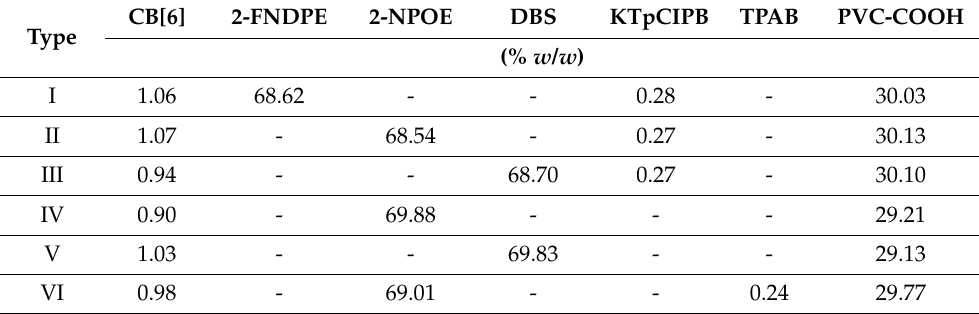
Table 1. Membrane composition (% w / w ) of the constructed electrodes for